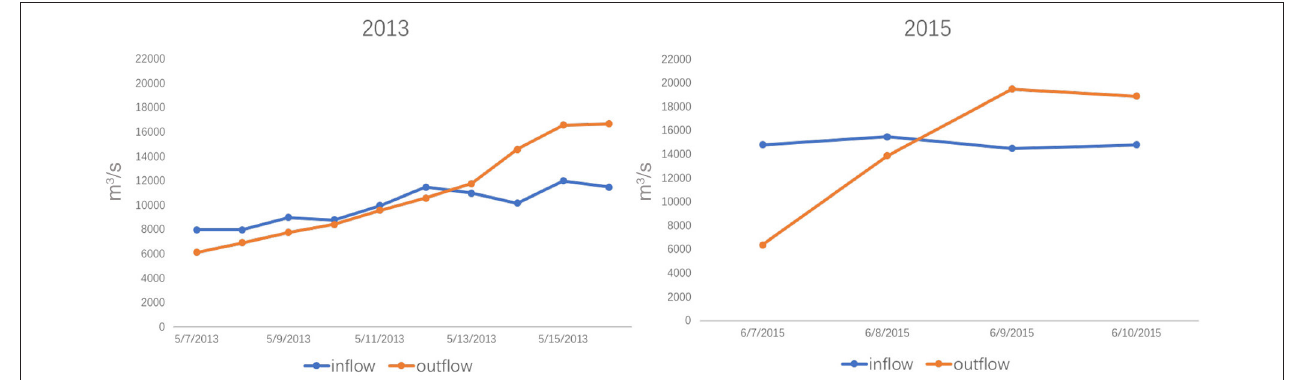
FIGURE 3 | Examples of environmental flow releases (m 3 /s) from Three Gorges Dam (2013 and